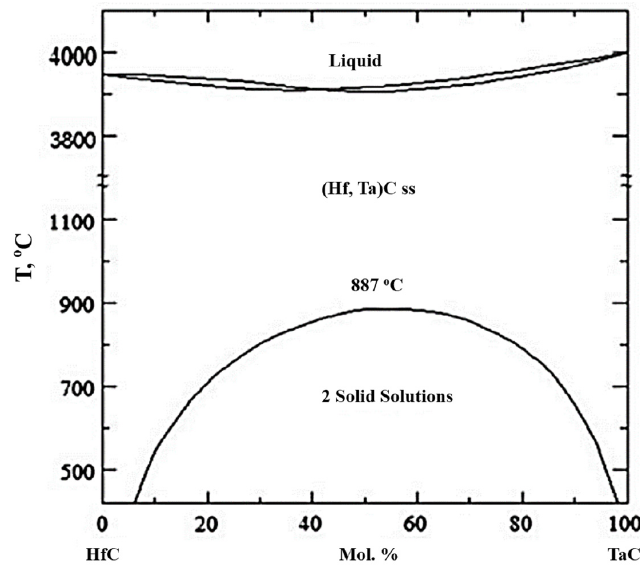
Figure 1. Phase diagram of TaC and HfC [15]. Copyright 2013 Elsevier.